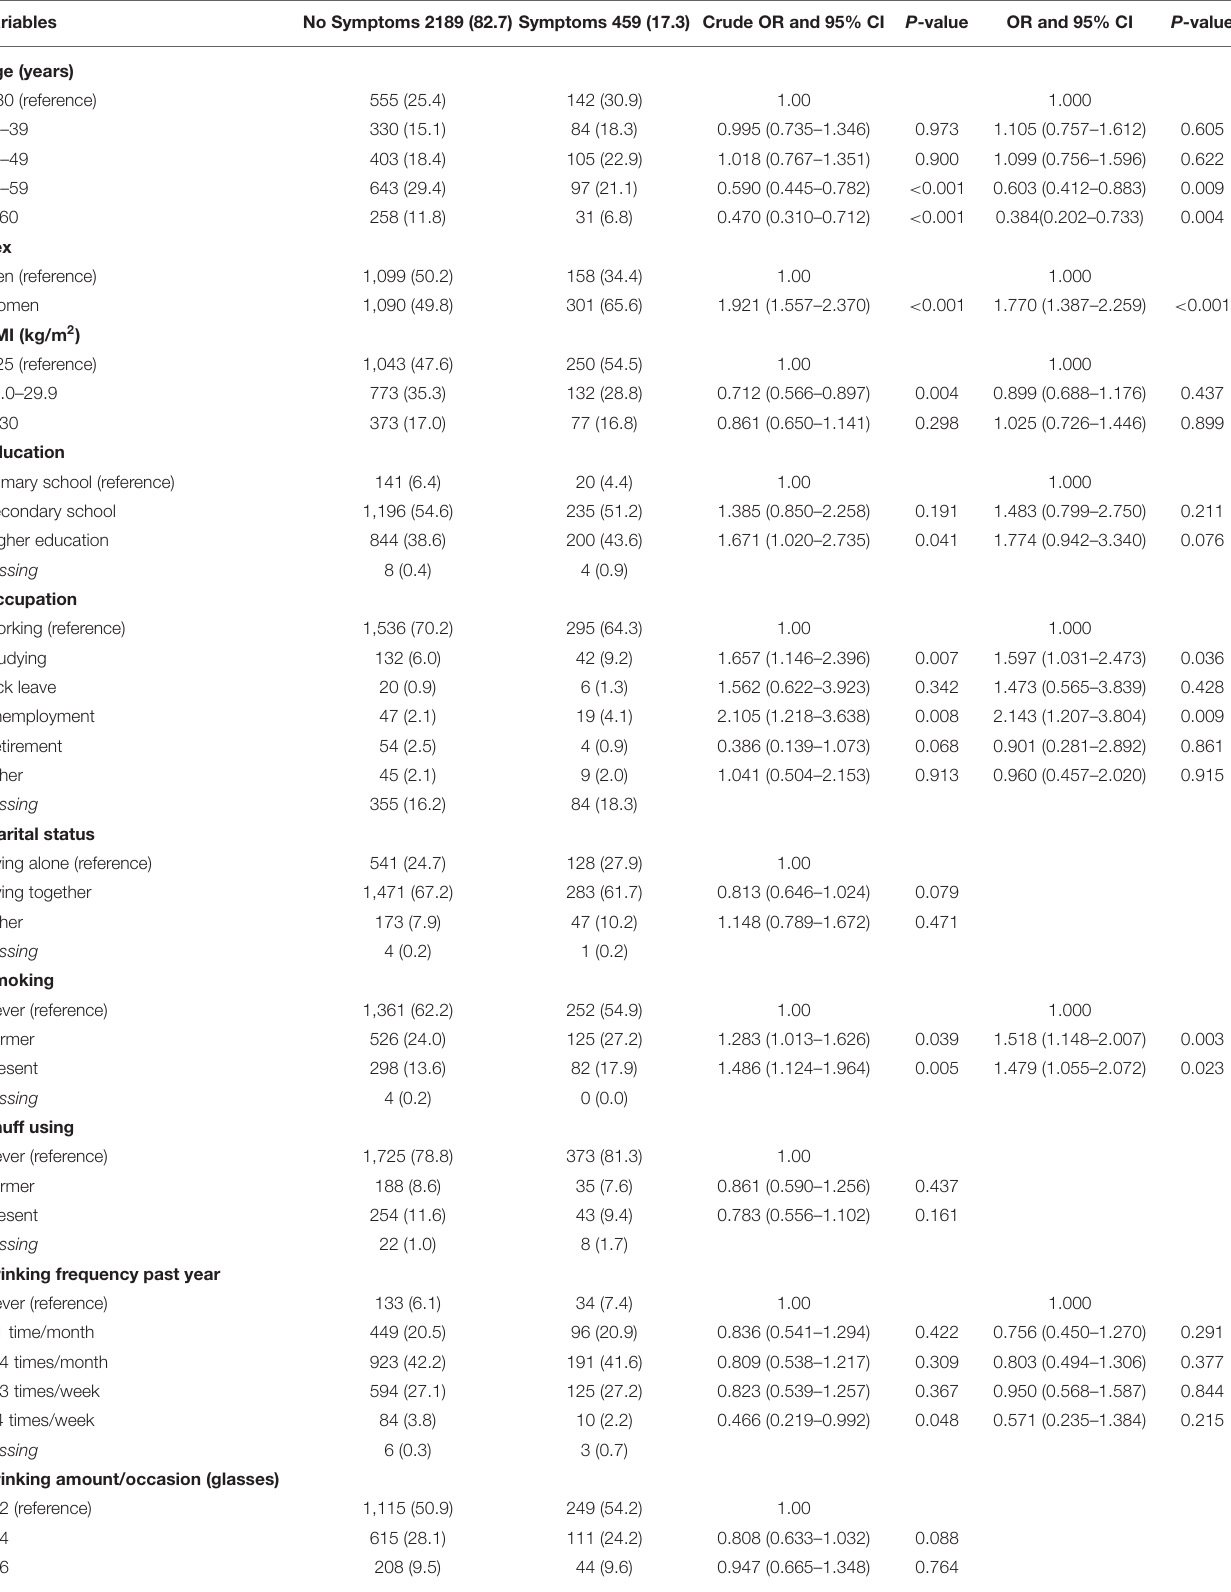
TABLE 4 | Association between sociodemographic status, lifestyle habits, and GI symptoms past 2 weeks.